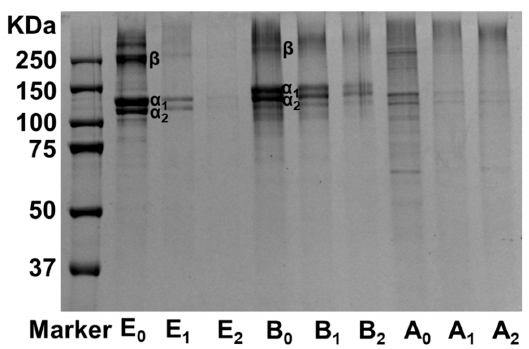
Figure 3. Sodium dodecyl sulfate polyacrylamide gel electrophoresis (SDS-PAGE) patterns of unmodified and MTGase modified type E gelatin, type B gelatin, and type A gelatin films.